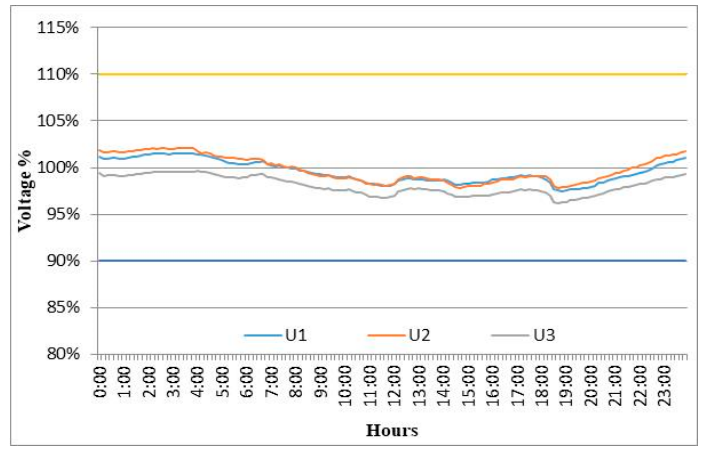
Figure 13. Comparison of the variation of the tension in steady state after the installation of the experimental system.